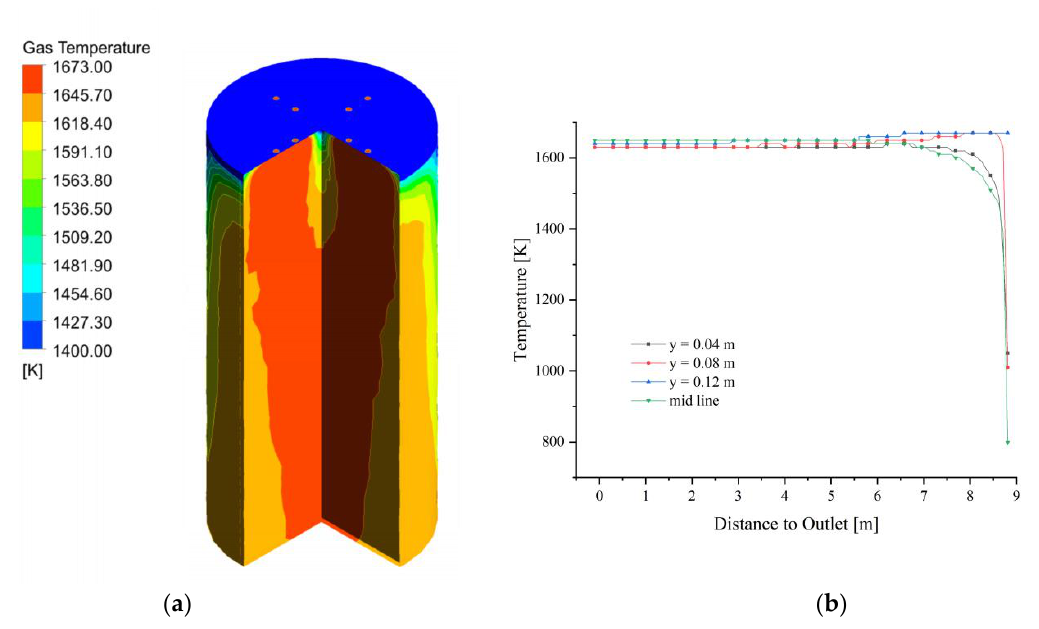
Figure 11. Gas temperature at 40 mm and 120 mm. ( a ) Gas temperature; ( b ) Gas temperature changes in y = 0.04, 0.08, 0.12 m, and mid line.